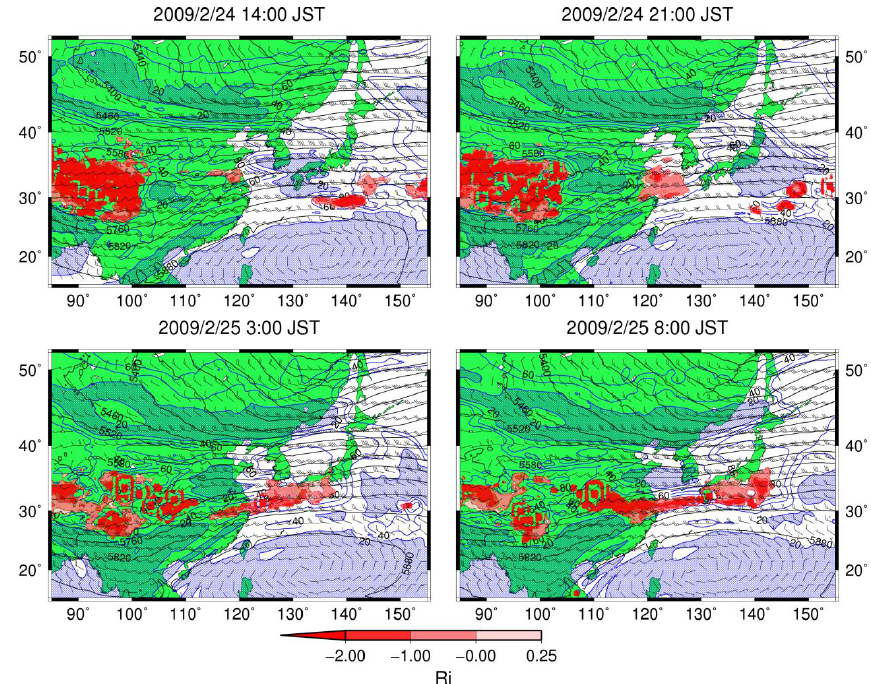
Fig. 11. Middle-troposphere instability in which the minimum bulk Richardson number was negative between the 400-hPa and 700-hPa layers, including a 500-hPa geopotential height, relative humidity (blue contour and the area of RH < 20% shaded by blue), and wind (each barb 10 m/s). The land areas are shown in green.